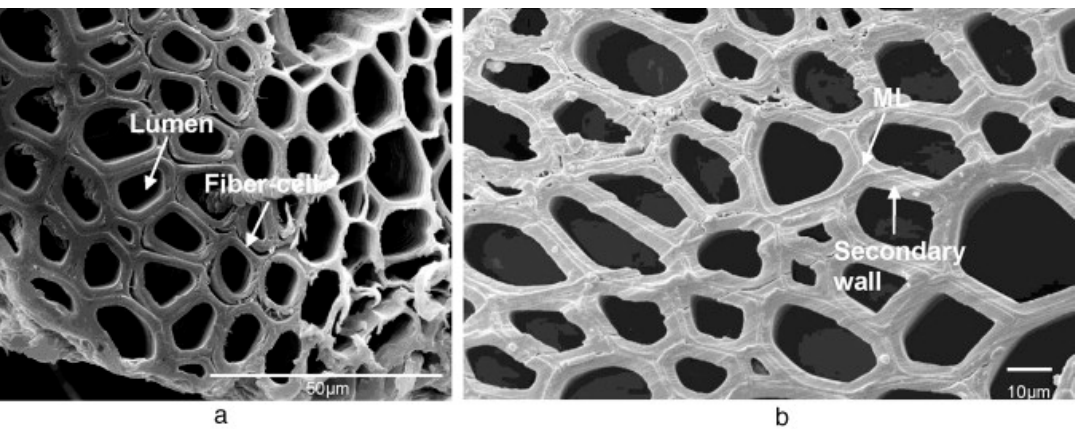
Figure 1. Two views at different magnifications (( a ): 1000 × ; ( b ): 2500 × ) of the sisal fiber cross-section [10]. (From open access publication).